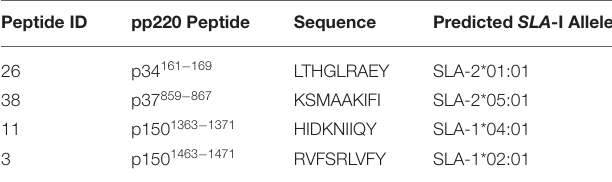
TABLE 3 | IFN- γ -inducing nonamer peptides from ASFV pp220 (Georgia 2007/1). Peptide